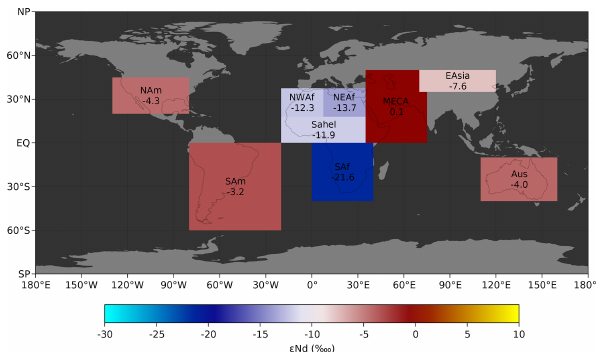
Figure 3. Extent of the dust regions of origin (Kok et al., 2021a, b; Adebiyi et al., 2020) and their ε Nd values as optimized in GNOM v1.0. See the text for region names.